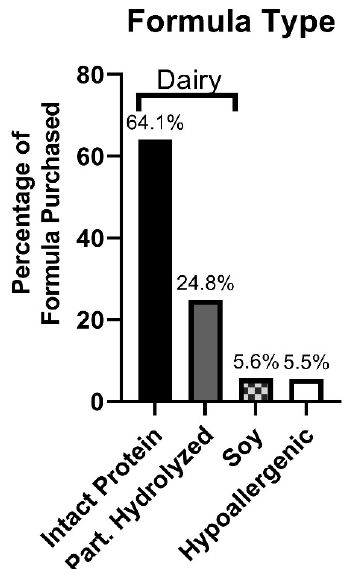
Figure 1. Types of infant formula purchased in the US between 2017–2019.